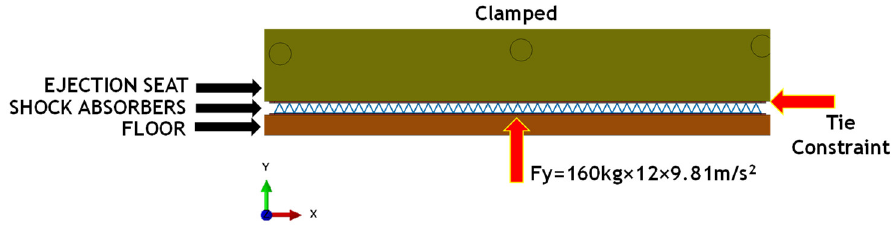
Figure 3. Scheme of the forces acting on the seat in the initial phase of the explosion.